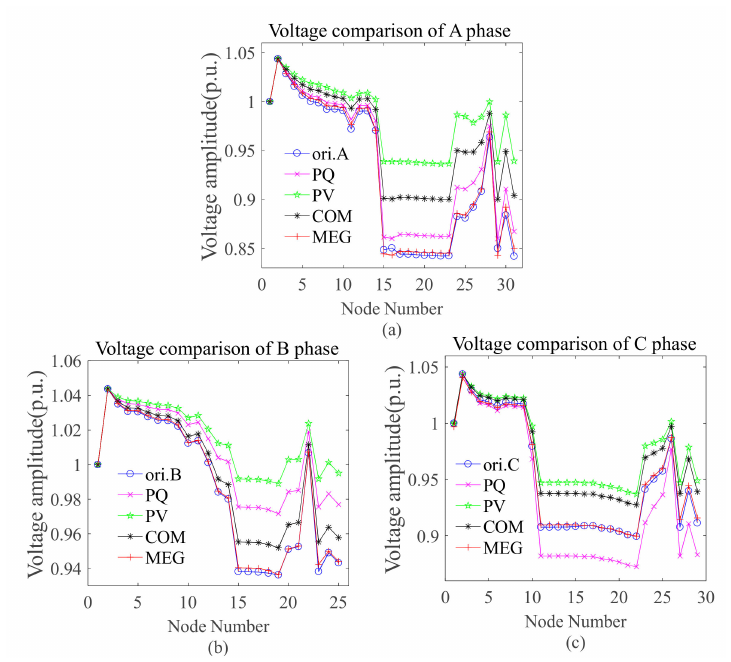
Figure 12. Three-phase voltage static simulation using di ff erent models in Scenario 2.